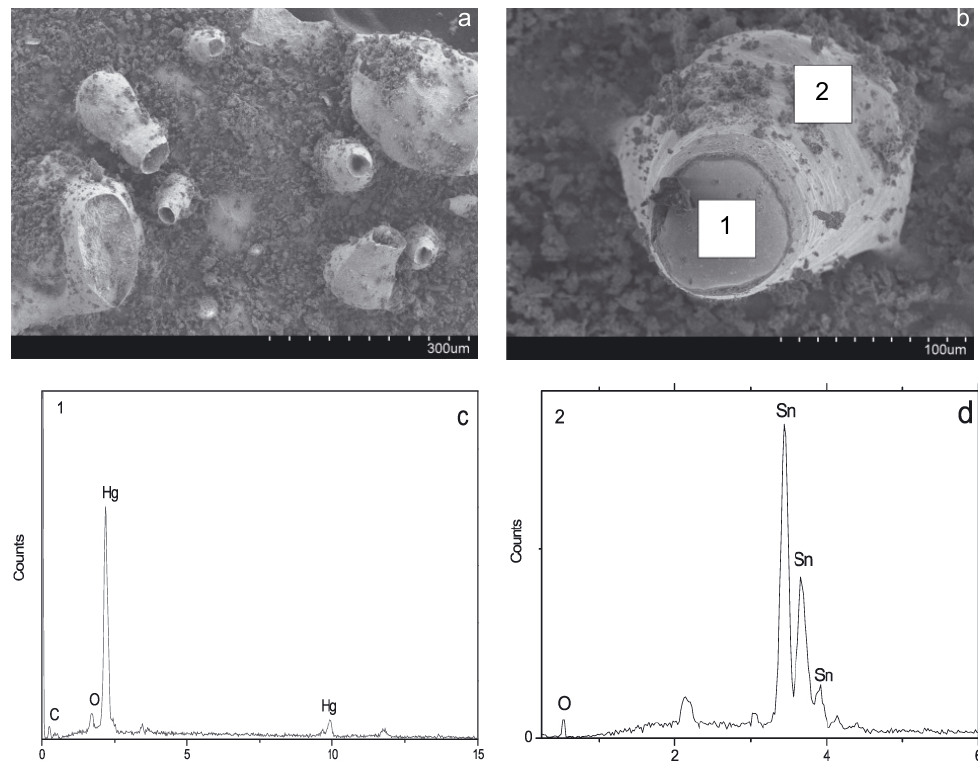
Figure 3. SEM microphotography of the heterogeneous corroded surfaces of the amalgam: (a) Sample 2, (b) Sample 3, (c) EDX analysis of a Hg drop on top of the craters-shaped holes, (d) EDX analysis of the